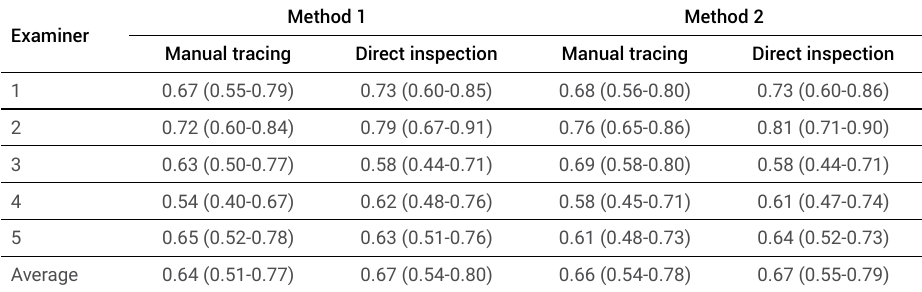
Table 2. Intraexaminers reliability between T1 and T2 moments according to weighted kappa coefficient and the reliable interval of